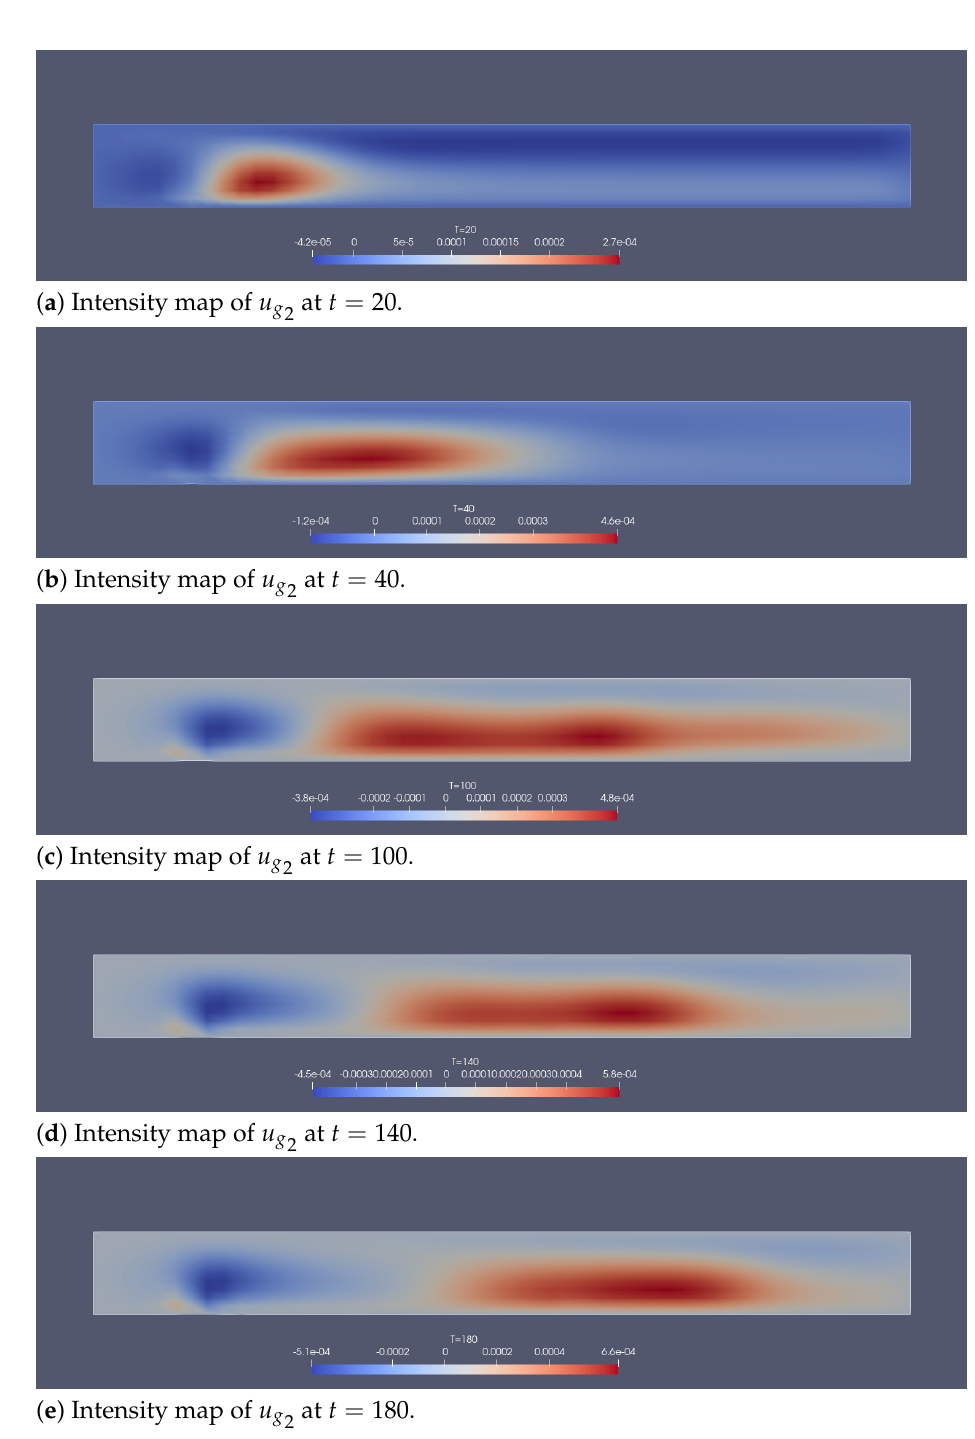
Figure 15. For Section 5.2: The vector fields u g and u l are very closed to Poiseuille flow. In this case, phase change and moving boundary contribute to the second component of u g (and u l ) together. The numerical test is conducted with δ t = 1 and 100 × 10 uniform mesh. The intensity maps indicate the bubble rising in the red region. Indeed, there exists high gas volume fraction region near the top side (see Figure